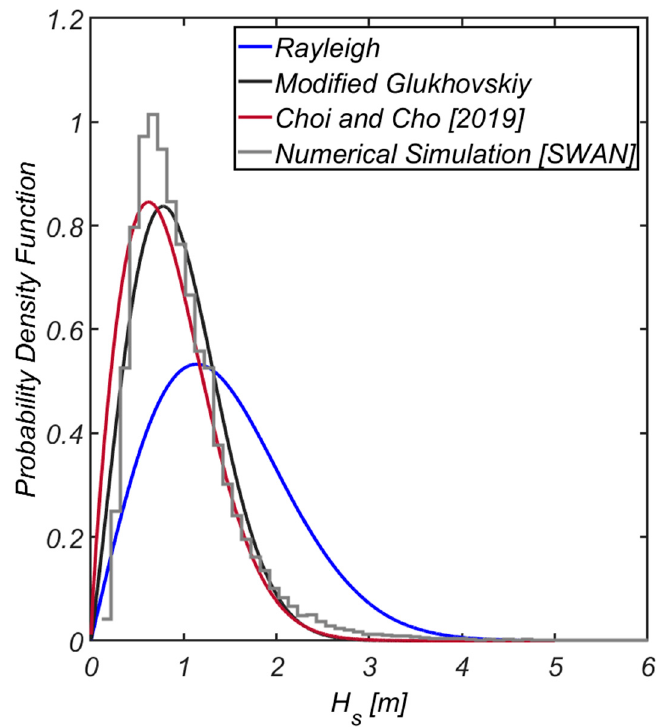
Figure 4. Comparison of wave height probability density functions by Choi and Cho [1] with the hindcasted wave data.